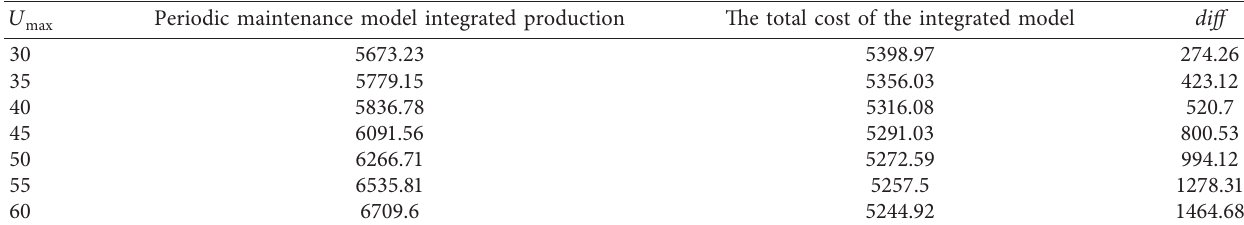
Table 9: The difference value between the periodic maintenance model integrated and integrated model ( U